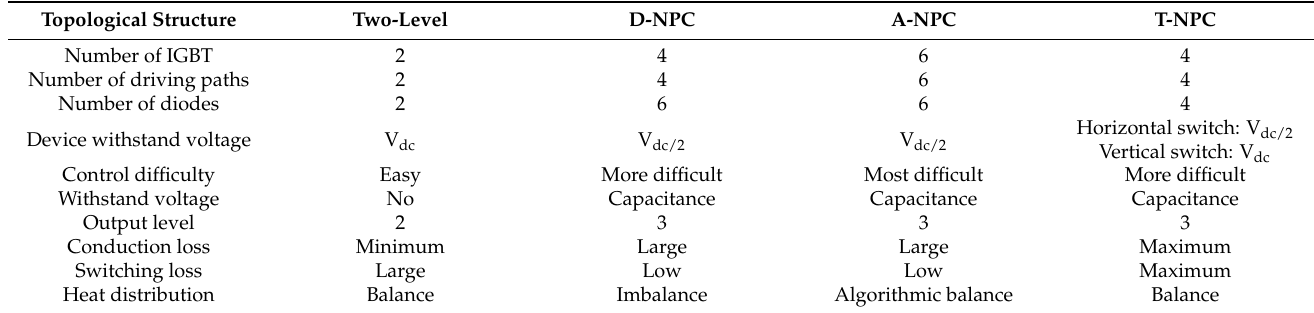
Table 1. The comparison of four traditional topologies.